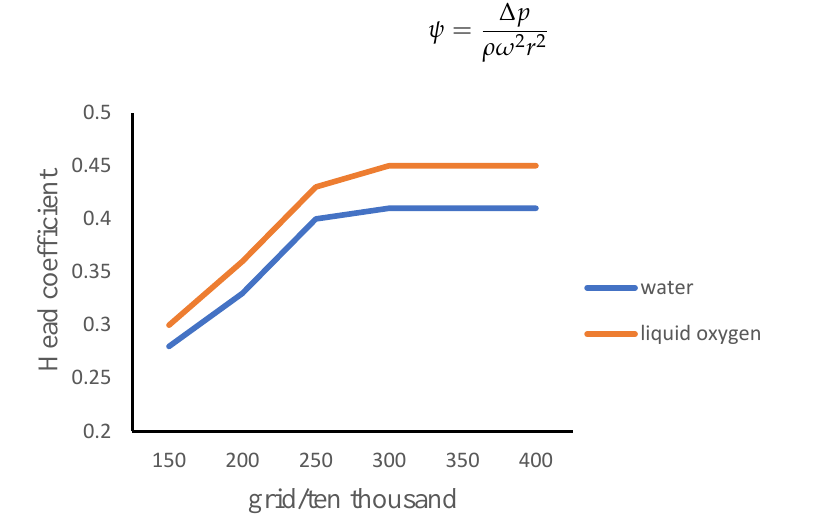
Figure 4. Variation of the head coefficient with the number of grids.